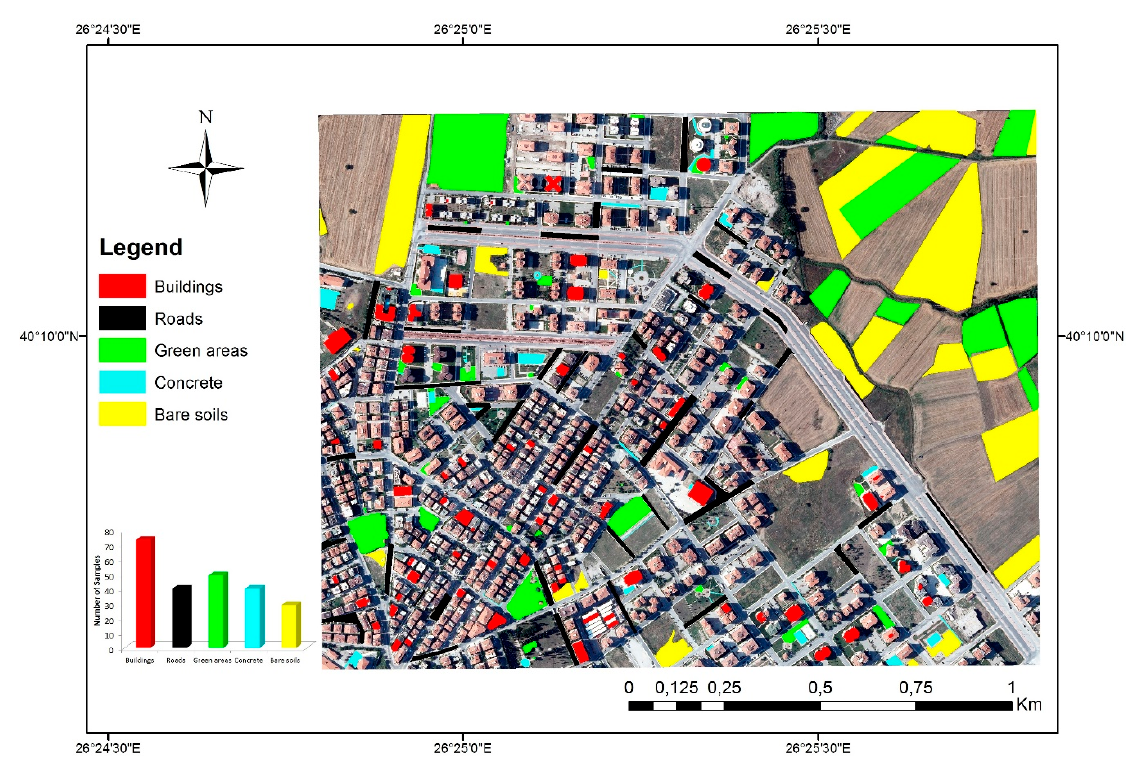
Figure 2. Sample distribution of LULC classes.